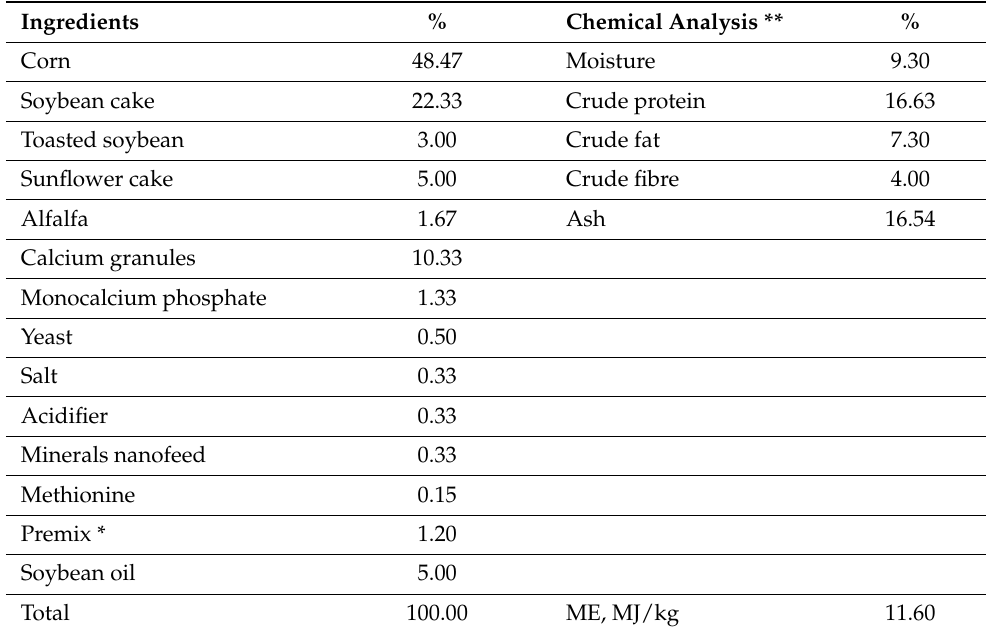
Table 1. Composition and chemical analysis of basic feeding